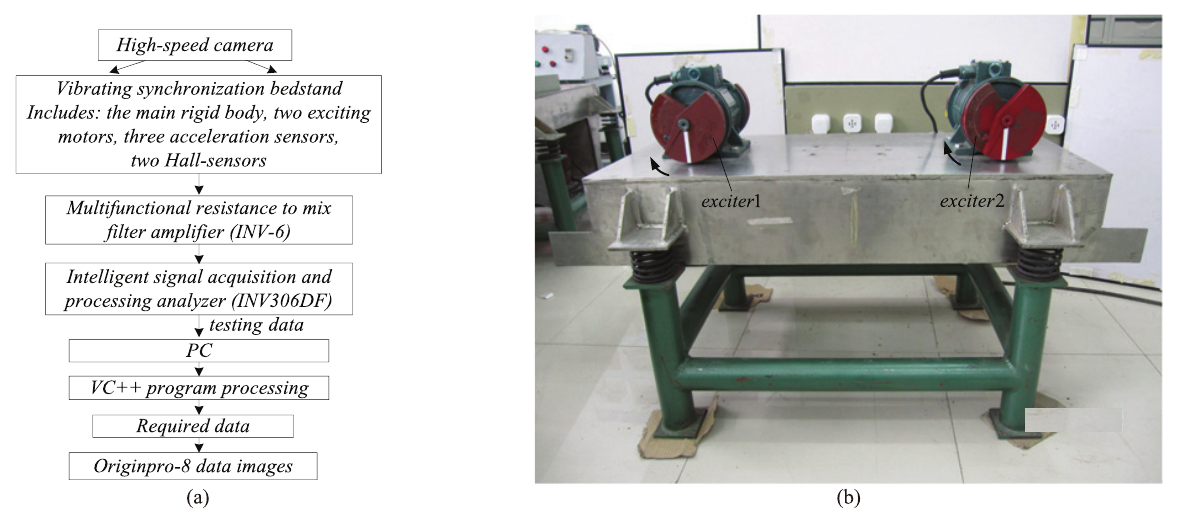
Fig. 7. A laboratory model of a vibrating system: (a) Schematic of experimental setup; (b) Vibrating synchronization